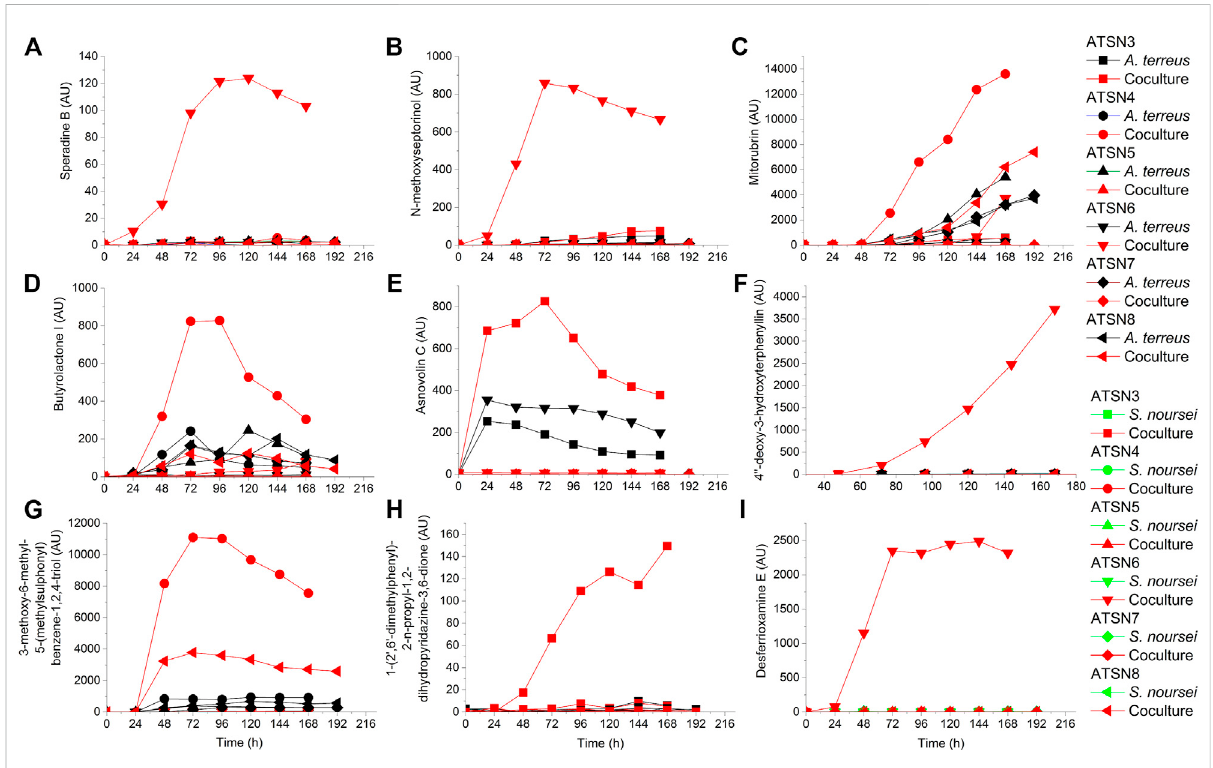
FIGURE 3 Production pro fi lesof secondary metabolites that weremarkedly stimulated under theconditions ofco-cultivation, namely (A) speradine B, (B) N-methoxyseptorinol, (C) mitorubrin, (D) butyrolactone I, (E) asnovolin C, (F) 4 ″ -deoxy-3-hydroxyterphenyllin, (G) 3-methoxy-6-methyl-5- (methylsulphonyl)benzene-1,2,4-triol, (H) 1-(2 ′ ,6 ′ -dimethylphenyl)-2-n-propyl-1,2-dihydropyridazine-3,6-dione, and (I) desferrioxamine (E) . AU — auxiliary